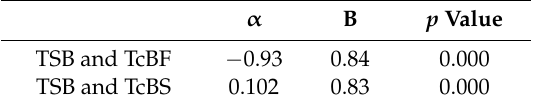
Table 2. Bivariate linear regression analysis of TSB and TcBF, TSB and